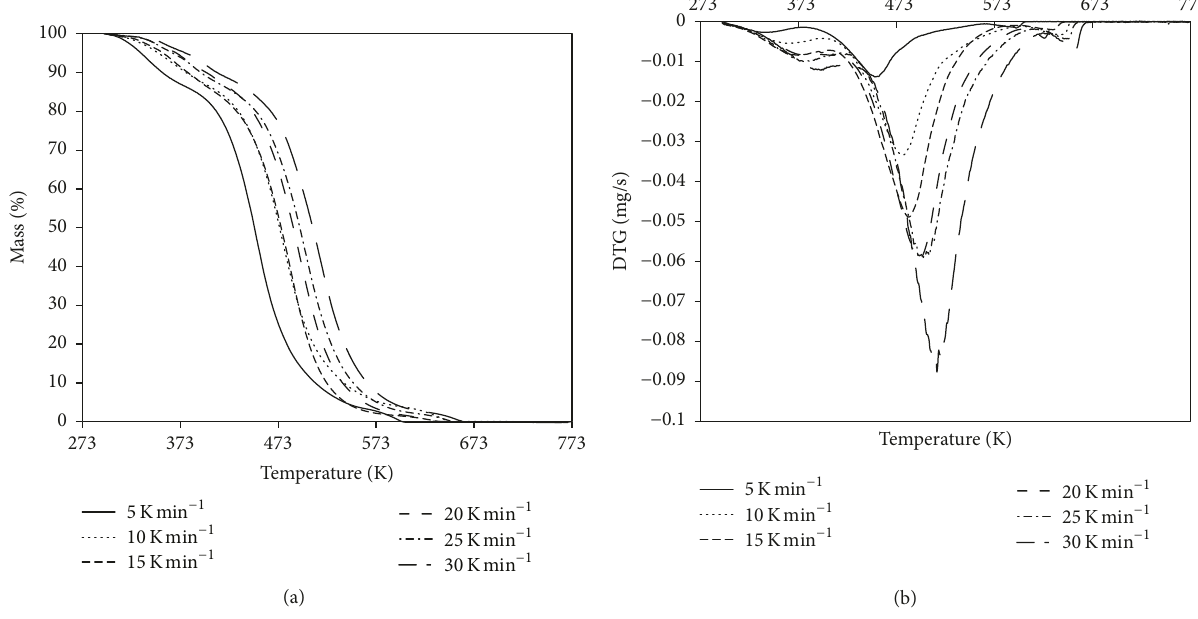
Figure 2: TG (a) and DTG (b) curves of lactic acid as a function of temperature and heating rates (5, 10, 15, 20, 25, and 30 K ⋅ min −1 ).